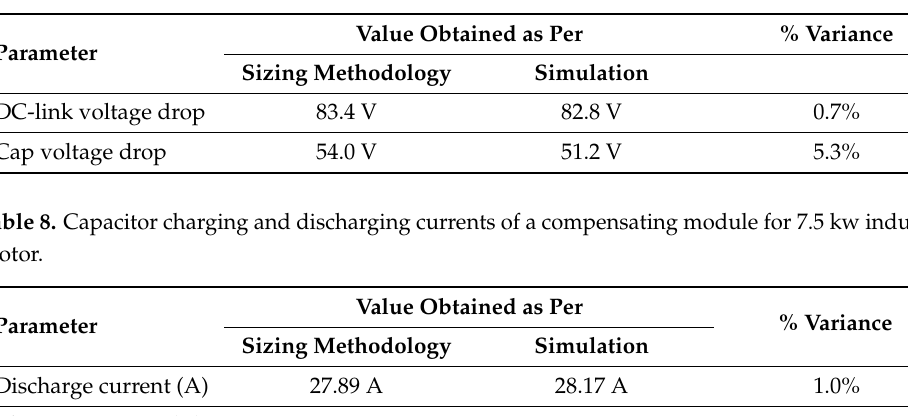
Table 7. DC-link and capacitor voltage variation during compensation of a 7.5 kW induction motor.